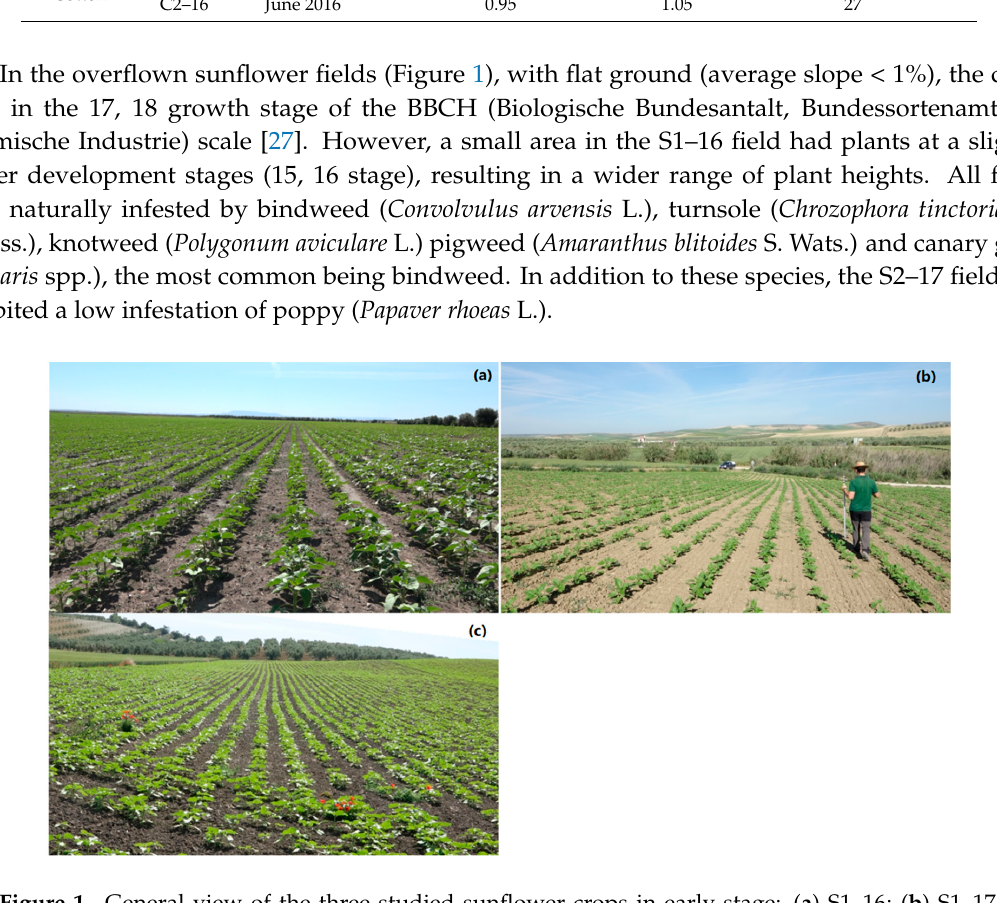
Table 1. Study fields and UAV-flight data.